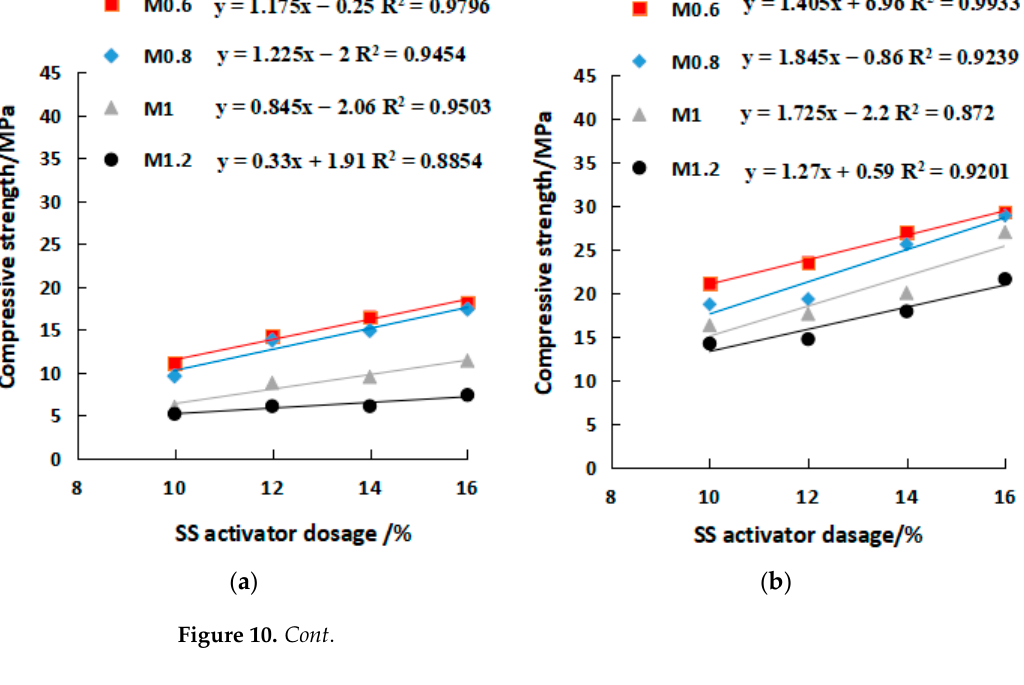
( c ) Figure 10. Relationship between compressive strength and SS activator dosage. ( a ) 3 days, ( b ) 7 days, ( c ) 28 days.